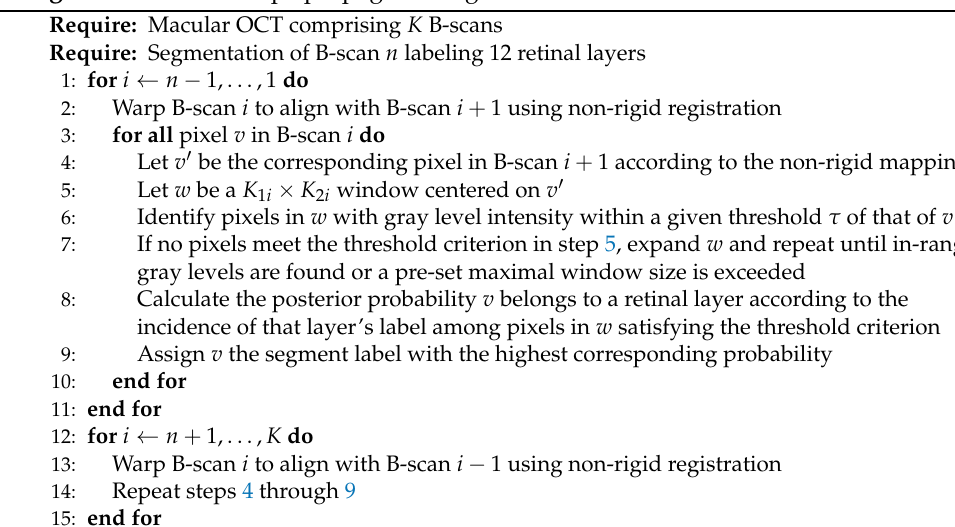
Algorithm 1: Prior shape propagation algorithm